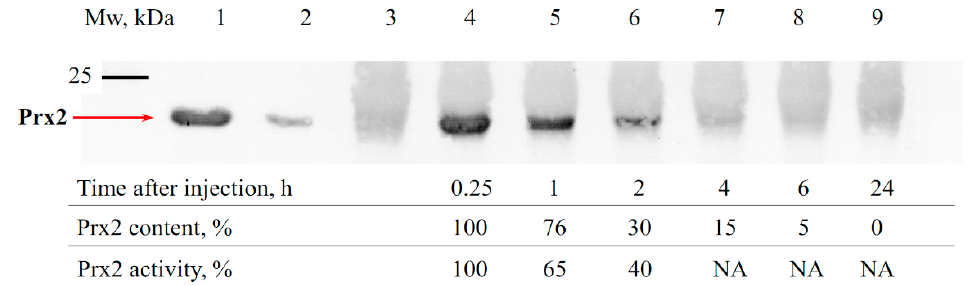
Figure 2. Immunoblotting of mouse blood serum after intravenous Prx1 injection. 1,2—purified recombinant Prx1 (500 and 100 ng, respectively); 3—blood plasma of control animals which did not receive Prx1; 4–8—blood serum samples of mice 0.25, 1, 2, 4, 6 and 24 h after intravenous injection of 1 mg of Prx1.